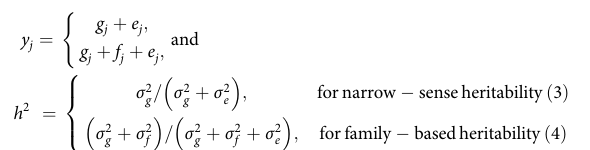
Table 11. To compare prediction accuracies between analyses, for instance, using fi rst- degree close relatives in the large-scale design against small-scale design, we computed the mean fold change across a variety of different traits with its 95% con fi dence interval and assessed the statistical signi fi cance level whether the fold change was signi fi cantly different from 1 with a two-tailed paired t